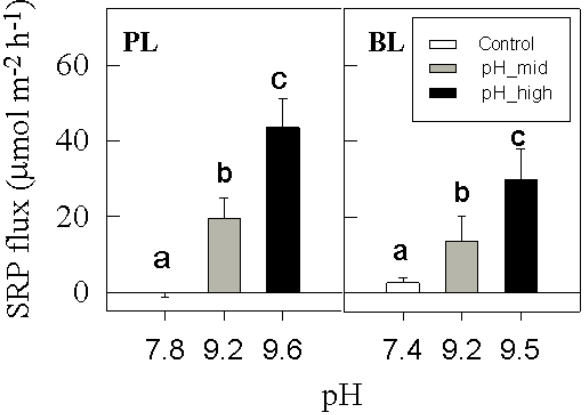
Figure 2. Experimental pH effects on SRP flux rates from sediments at Powerline (PL) and Budds Landing (BL). Error bars are the standard errors. Two-way ANOVA was used to test the pH effects on SRP release at both sites. With elevation in the experimental pH, SRP fluxes were significantly different at each site (P < 0.01), but non-significantly different between stations (P > 0.05). Different letters are used to show significant difference.